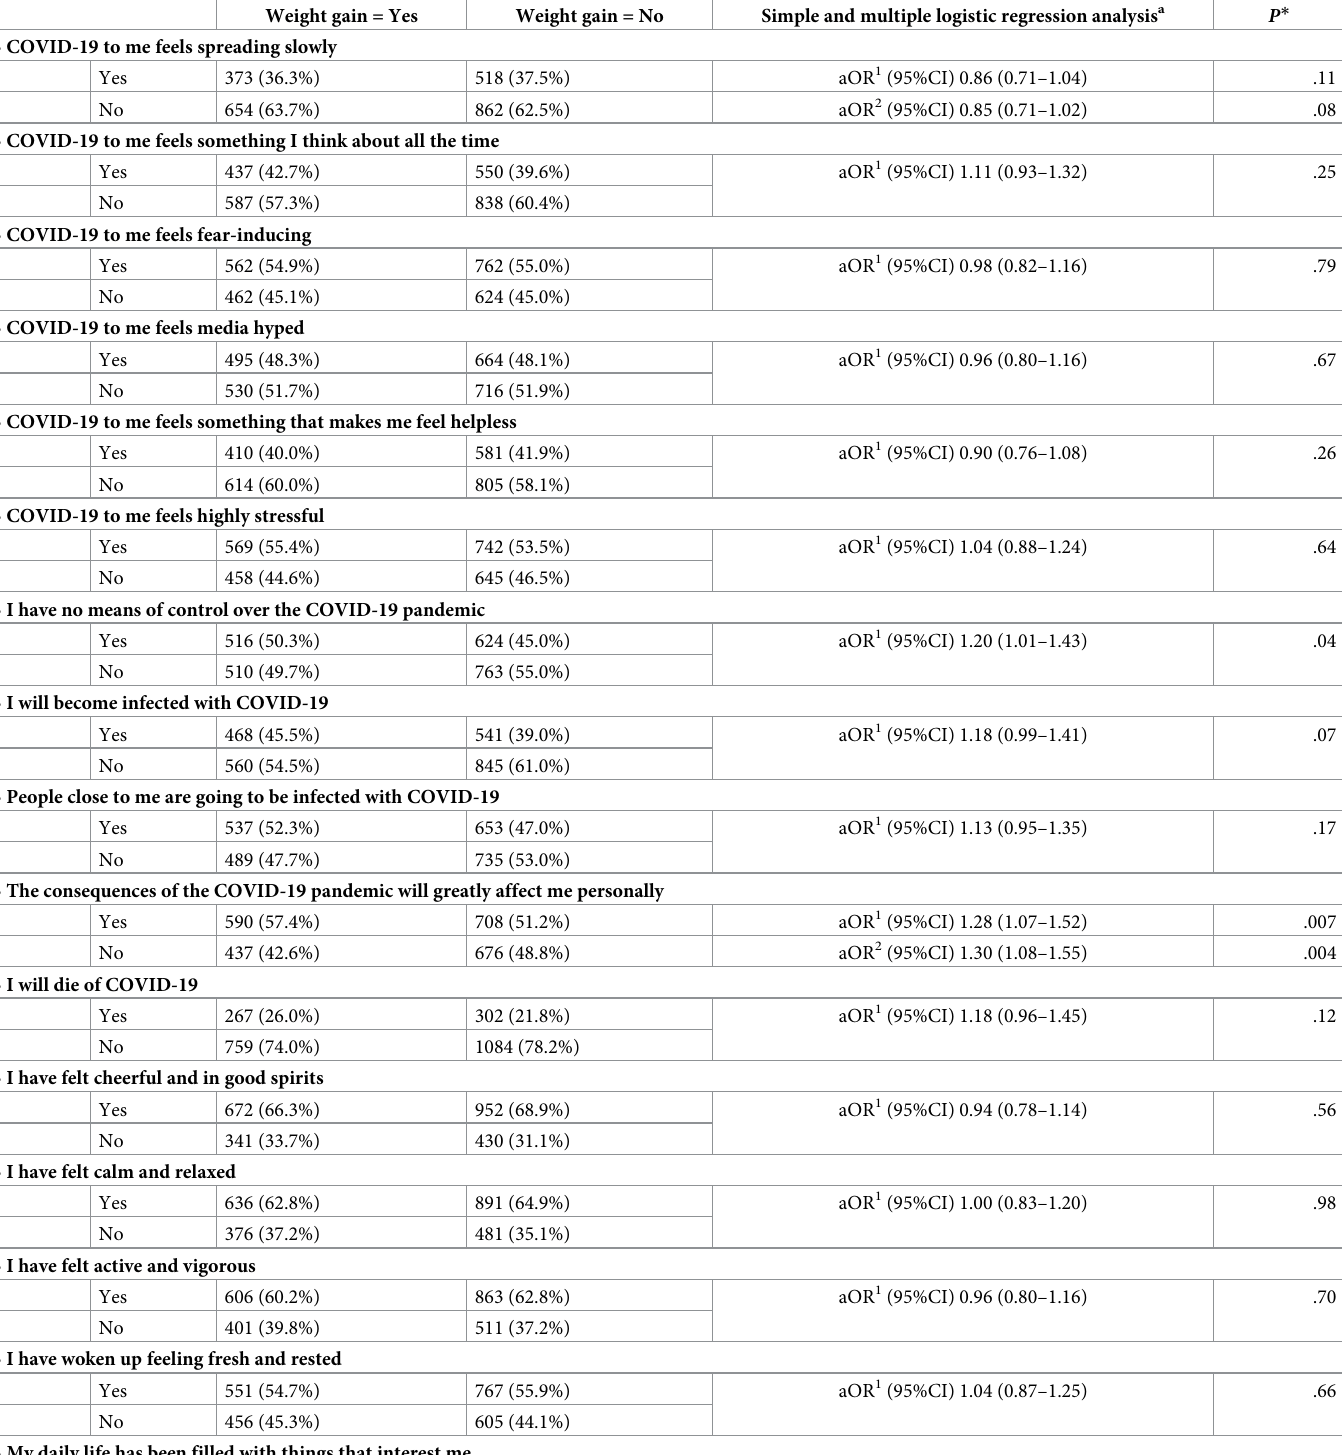
Table 5. Associations between COVID-19 related mental health outcomes and weight